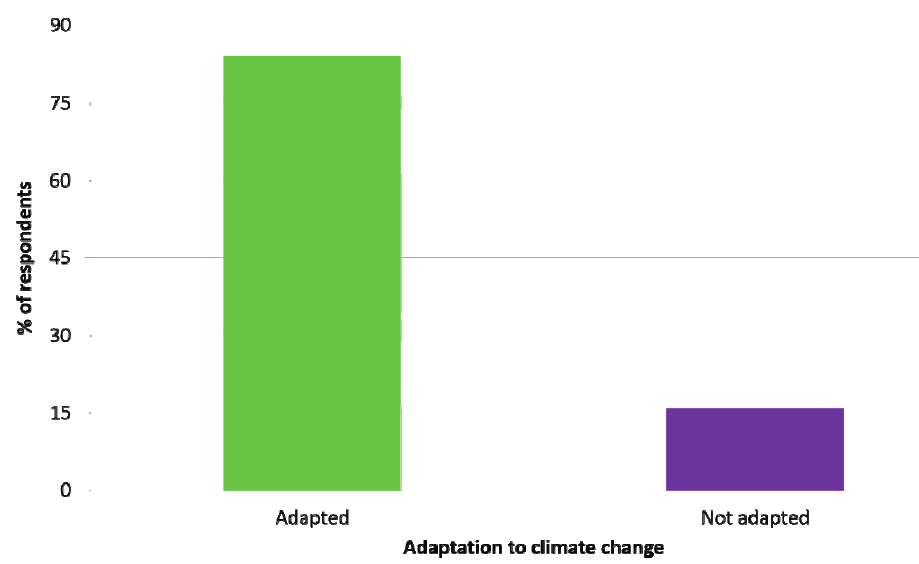
Figure 2. Proportion of respondents by adaptation